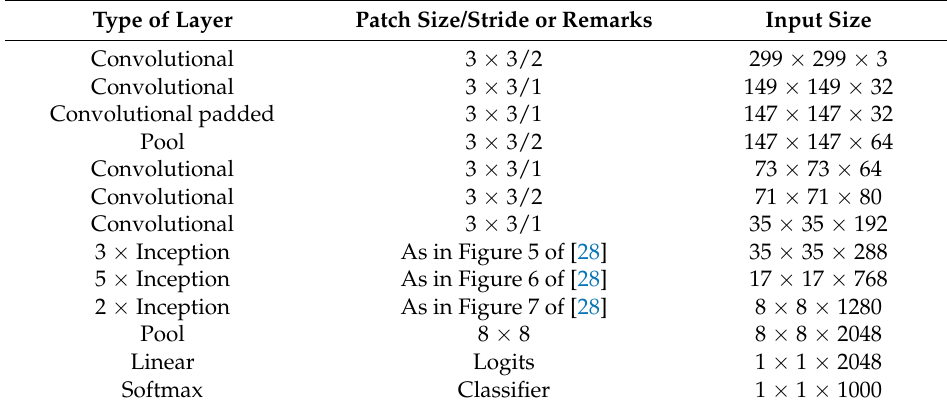
Table 1. The architecture of Inception V3. The output size of each module is the input size of the next one. The three dimensions of “input size” are width, height , and channel dimension.